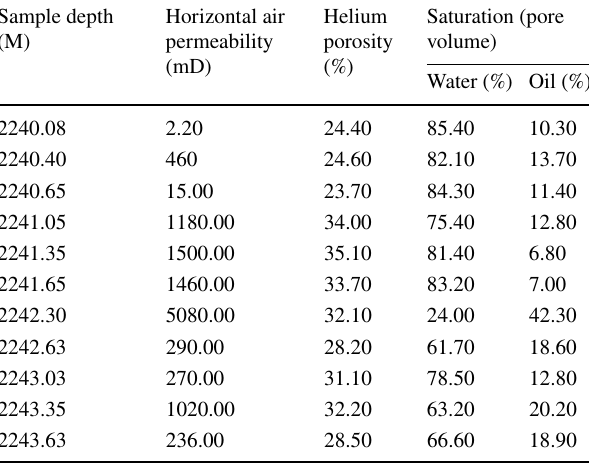
Table 2 Petrophysical data of PZ-4 well, Niger Delta